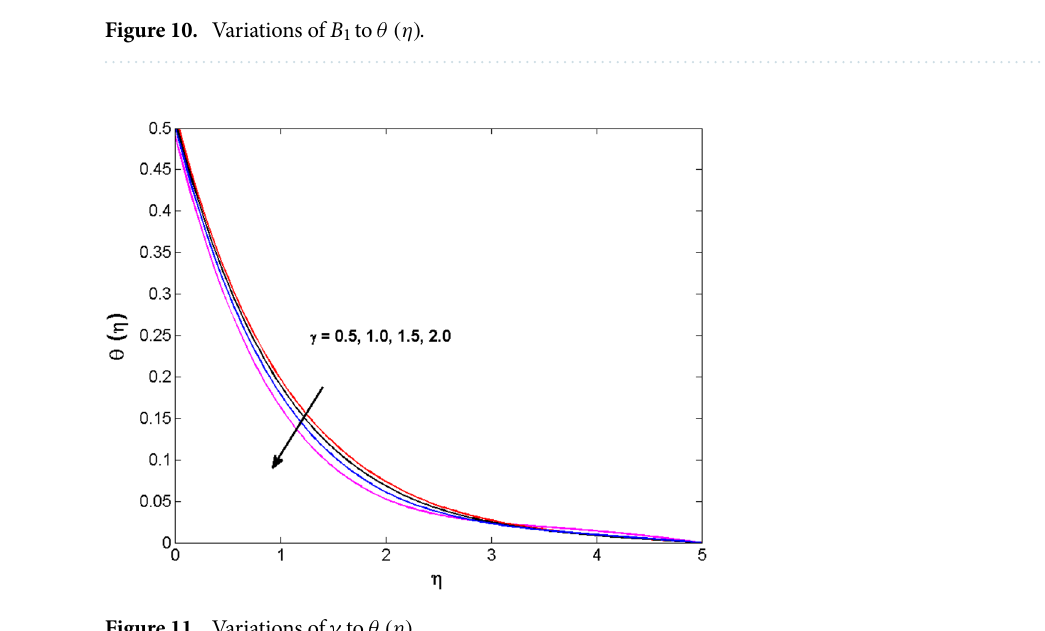
Figure 11. Variations of γ to θ (η) .